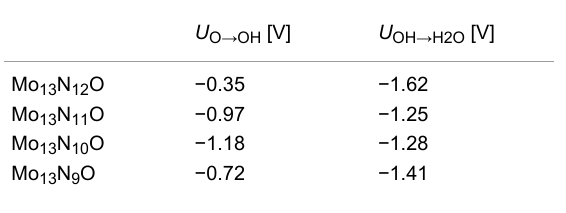
The free energies for oxygen absorption are shown in Table 1 for neutral bias and the potential needed for ammonia produc- tion, and listed together with the energies for nitrogen and hydrogen (from [2]). At neutral bias, oxygen is the preferred adsorbate with adsorption energies of − 1.58 eV increasing to − 2.15 eV. Under these conditions, the vacancy sites will be filled with oxygen and block nitrogen molecules from adsorbing to the active sites and stop the electrochemical formation of ammonia.